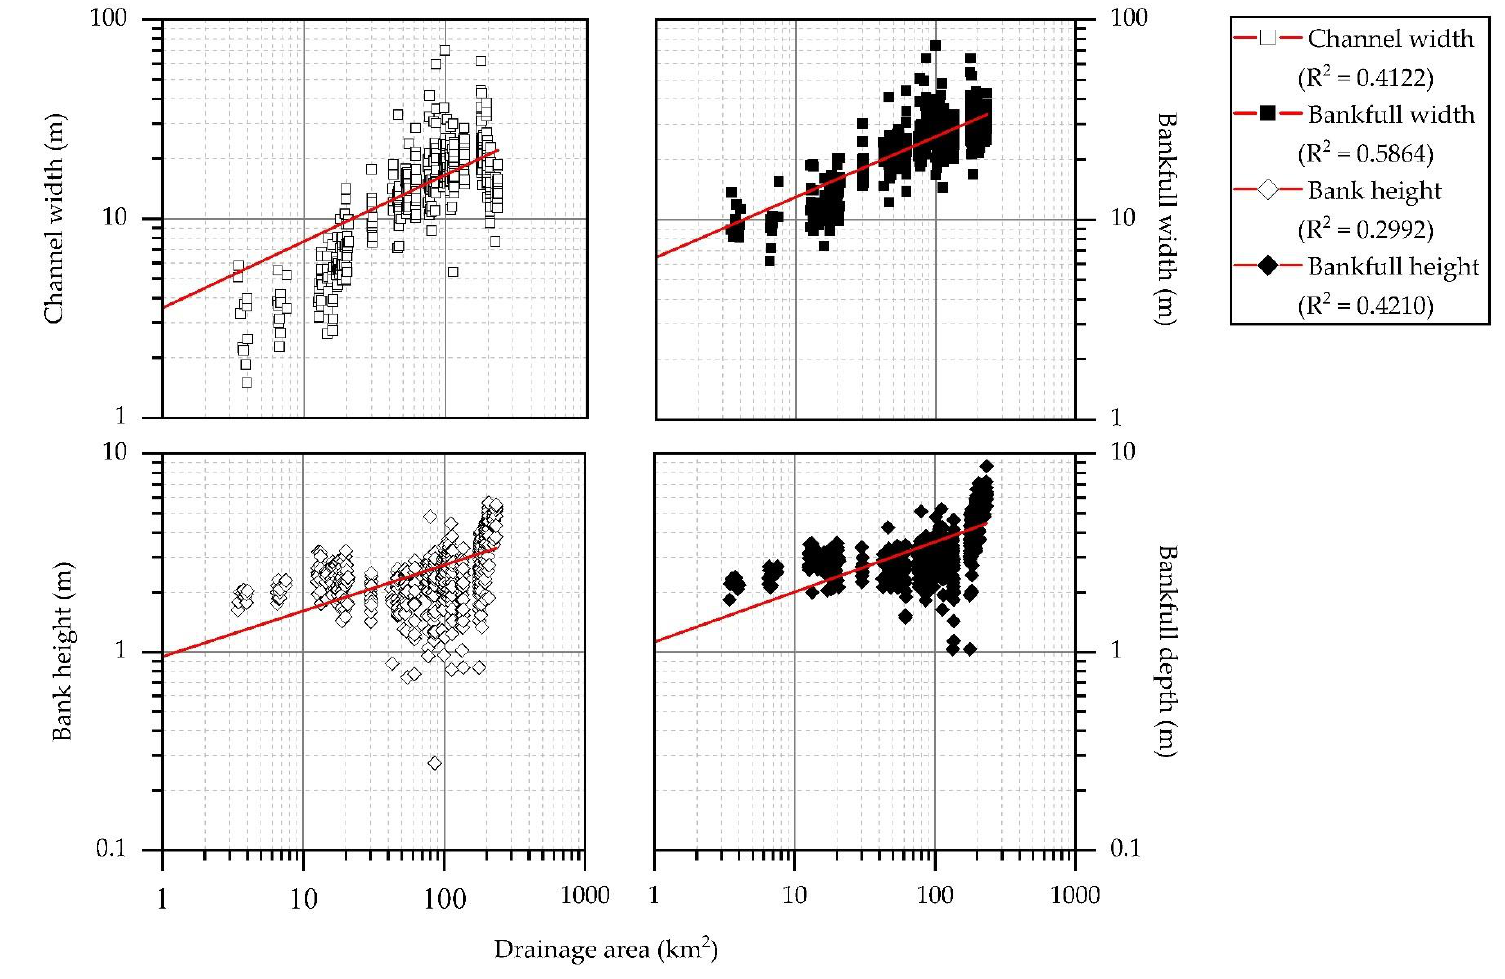
Figure 2. Power relationships between drainage area and observed channel morphological metrics in Hinkson Creek Watershed, Missouri, USA.